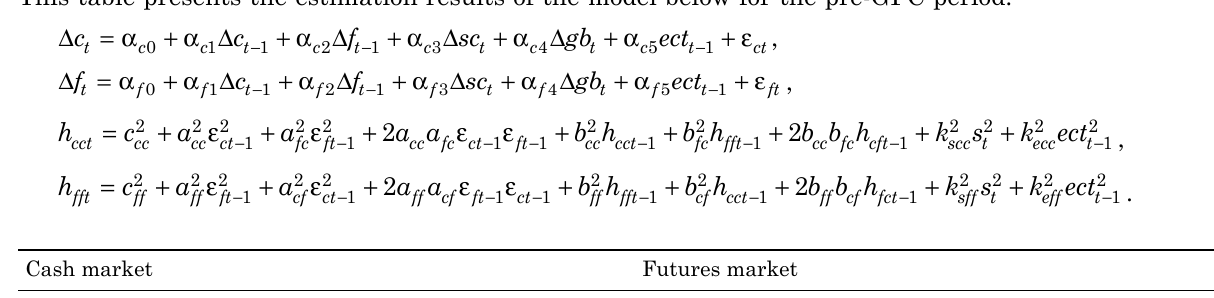
table 4. estimation of the ec-Var-BeKK-garcH-X model pre-gfc this table presents the estimation results of the model below for the pre-gfc